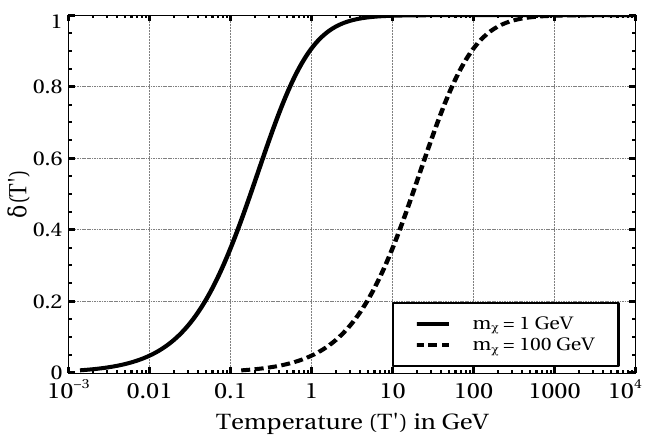
Figure 2 . Variation of δ ( T 0 ) with temperature T 0 for two different values of m χ